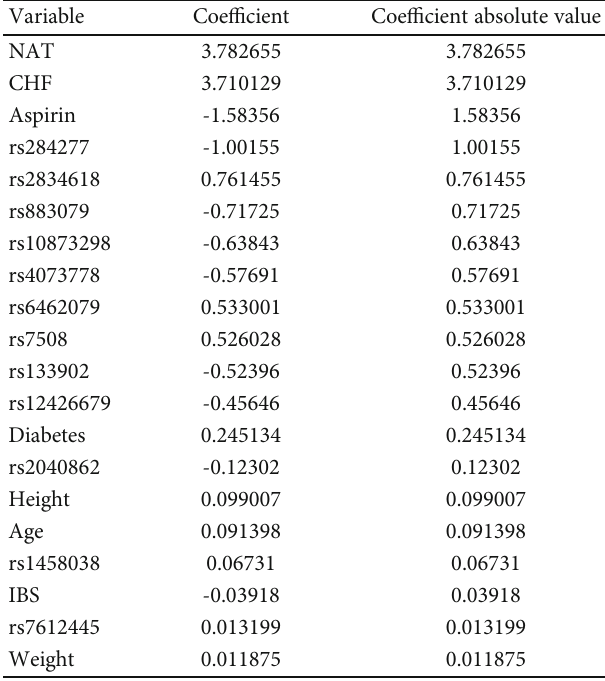
Figure 3: The area under the curve for each fi tting model used in the machine learning analysis. Table 5: Coe ffi cients of the association from the